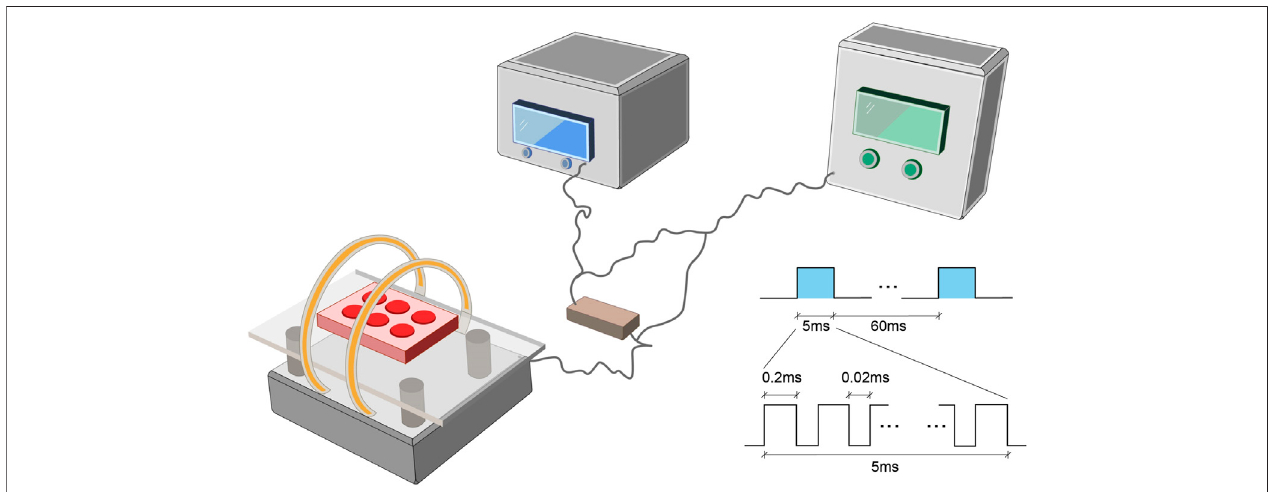
FIGURE 1 | The PEMF exposure system and output waveform. The PEMF device was composed of a signal generator with two Helmholtz coils. A compact 2 Ω resistor wascarefullypositioned in series with coils. ThePEMF waveform was composed ofapulsed burst (burst width, 5 ms; pulse width, 0.2 ms; pulse wait, 0.02 ms; burst wait, 60 ms; pulse rise, 0.3 µs; pulse fall, 2.0 µs), frequented at 15 Hz. PEMF, Pulsed Electromagnetic